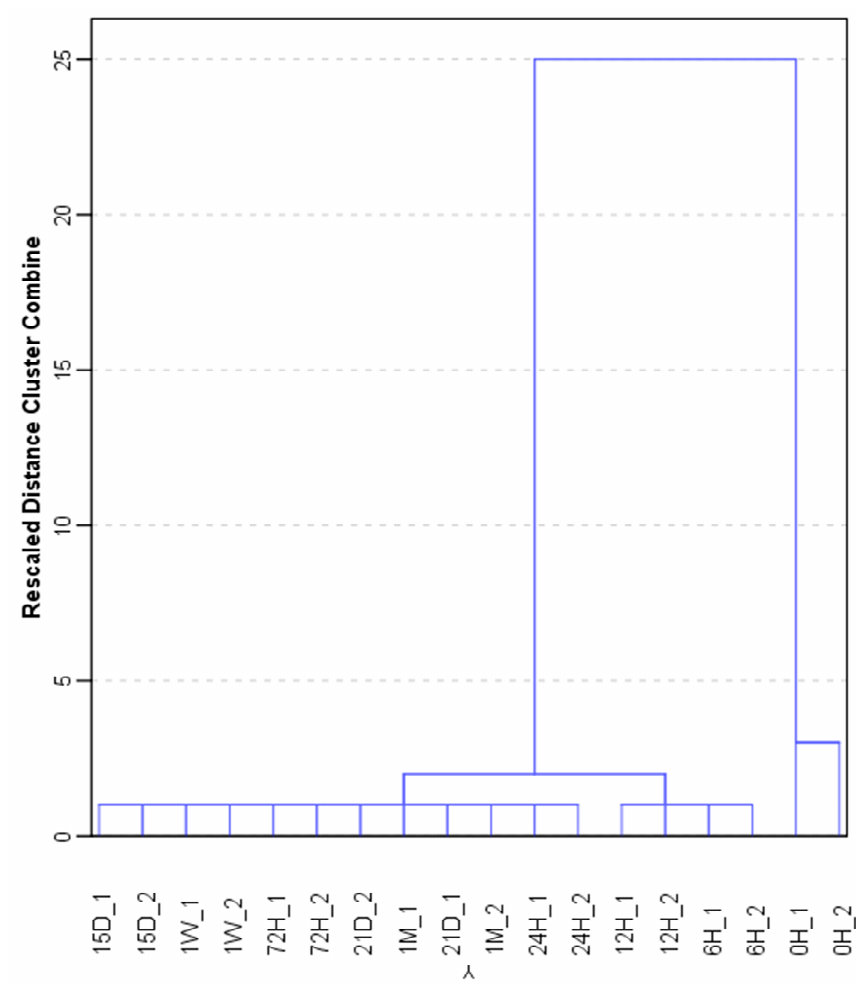
Figure 2. Dendrogram for 40 µL gasoline samples supported on cotton sheets for up to one month.